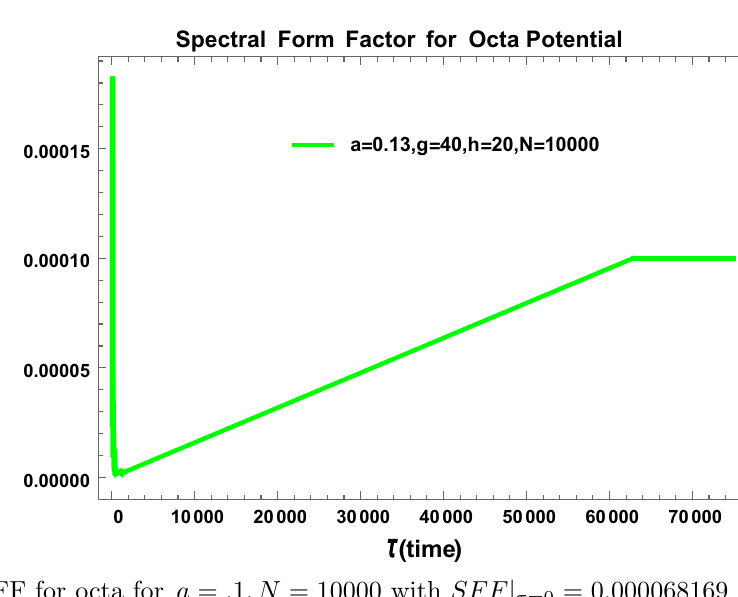
Footnote 23 continued really neglect the expansion of the universe. This further